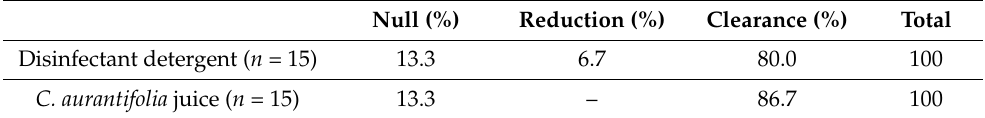
Table 1. Effectiveness of commercial disinfectant detergent and C. aurantifolia juice (%) as cleaning agents. Null (%)